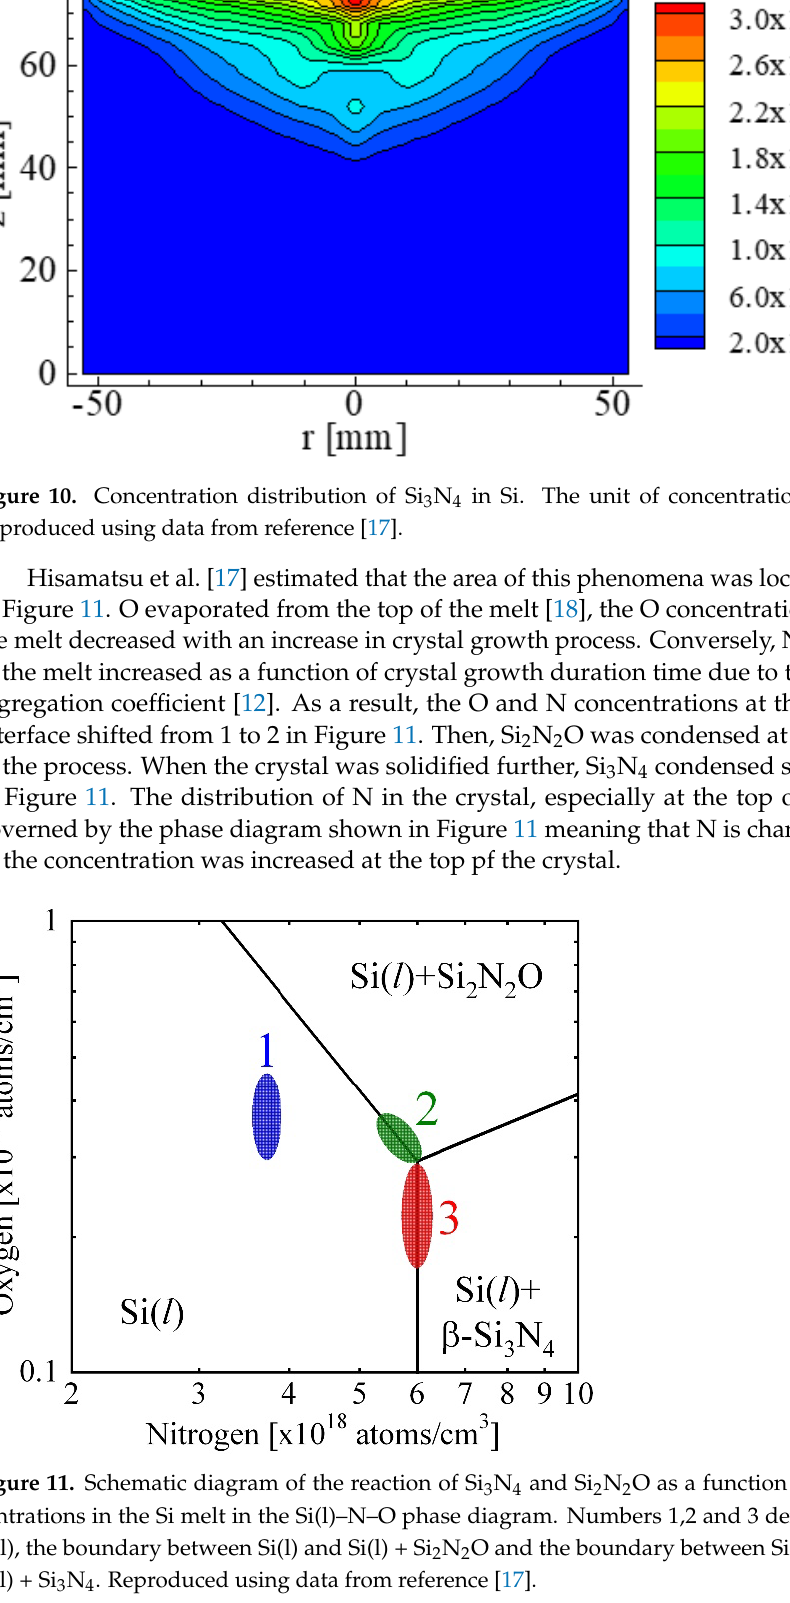
Figure 9. Concentration distribution of N in an Si crystal and melt. The unit of concentration is at- oms/cm 3 Reproduced using data from reference [17].